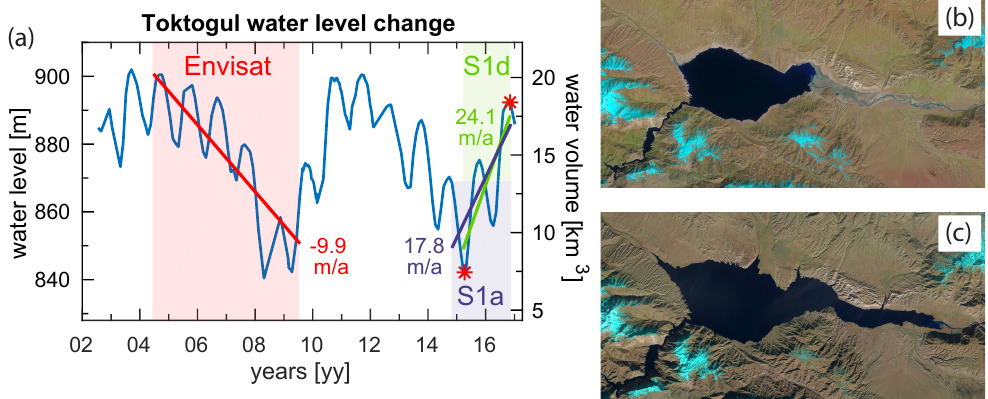
Figure 2. ( a ) Toktogul water level change between 2002 and 2016 obtained from satellite radar altimetry. Red, purple and green highlighted periods correspond to Envisat and Sentinel-1 ascending (S1a) and Sentinel-1 descending (S1d) acquisition times, respectively. The corresponding regression lines denote the average water increase per year for each of the three SAR time series (note that differences between S1a and S1d are due to different covered time periods). The red asterisks correspond to the reservoir extents at low and high water levels, which are shown by Landsat-8 images from ( b ) 11.04.2015 and ( c ) 07.11.2016,